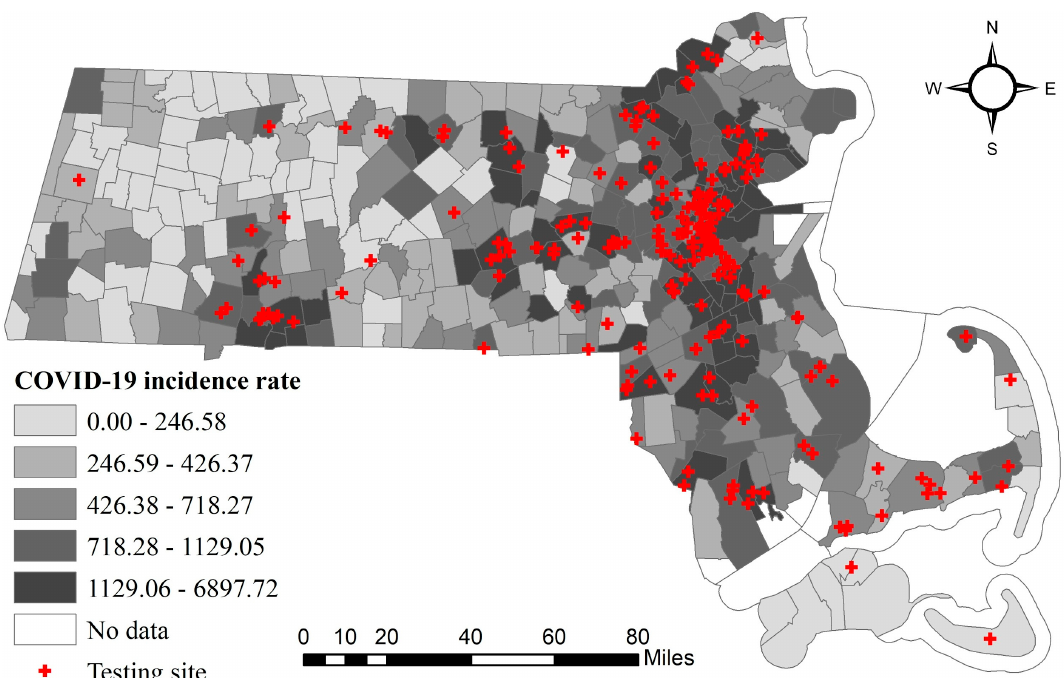
Figure 1. City/town-level accumulated COVID-19 incidence rate (confirmed cases/per 100,000 people) Figure 1. City / town-level accumulated COVID-19 incidence rate (confirmed cases / per 100,000 people) and testing sites in Massachusetts as of 20 May 2020. and testing sites in Massachusetts as of 20 May